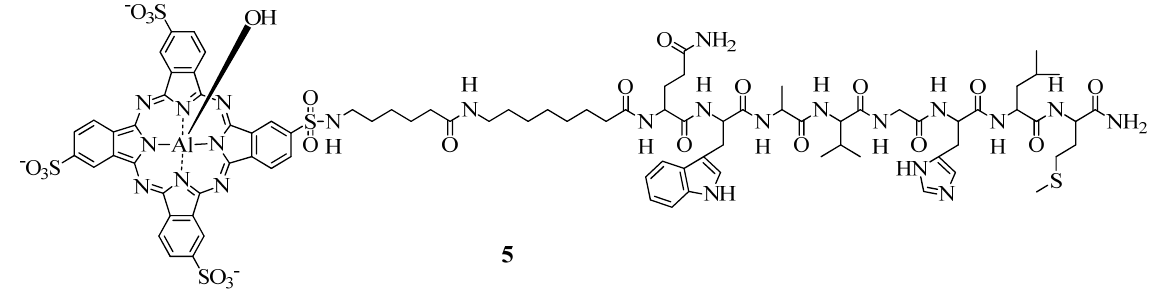
conjugate 5 for the targeting of 4